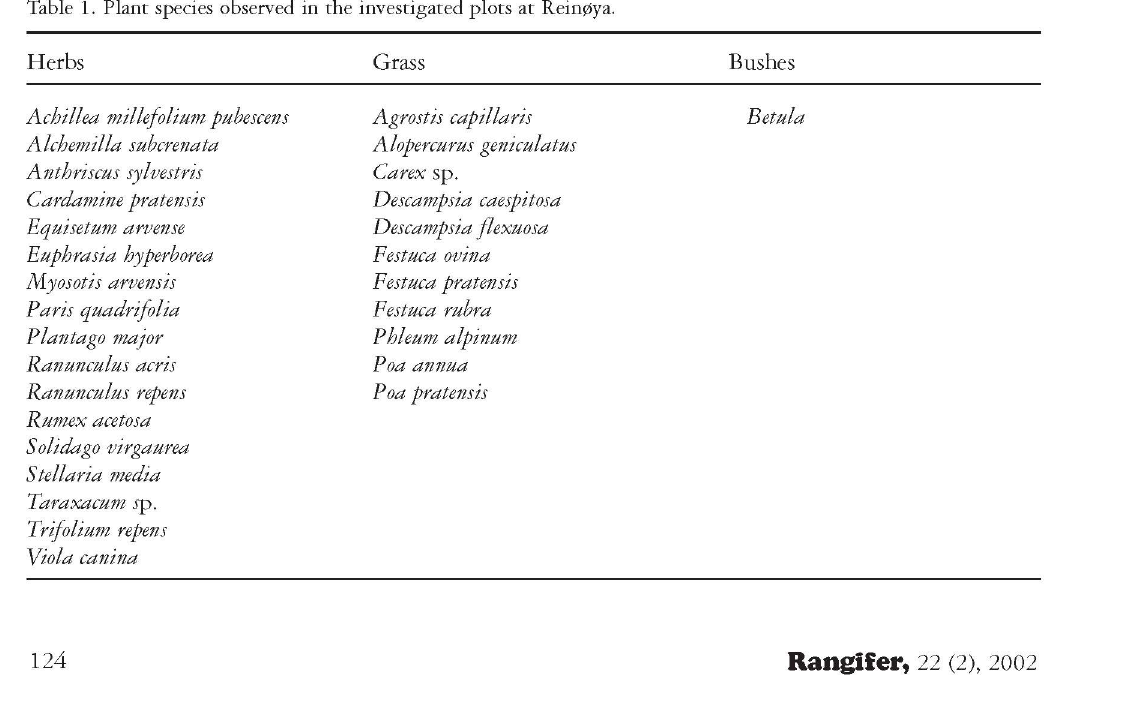
Table 1. Plant species observed in the investigated plots at Reinøya. Herbs Grass